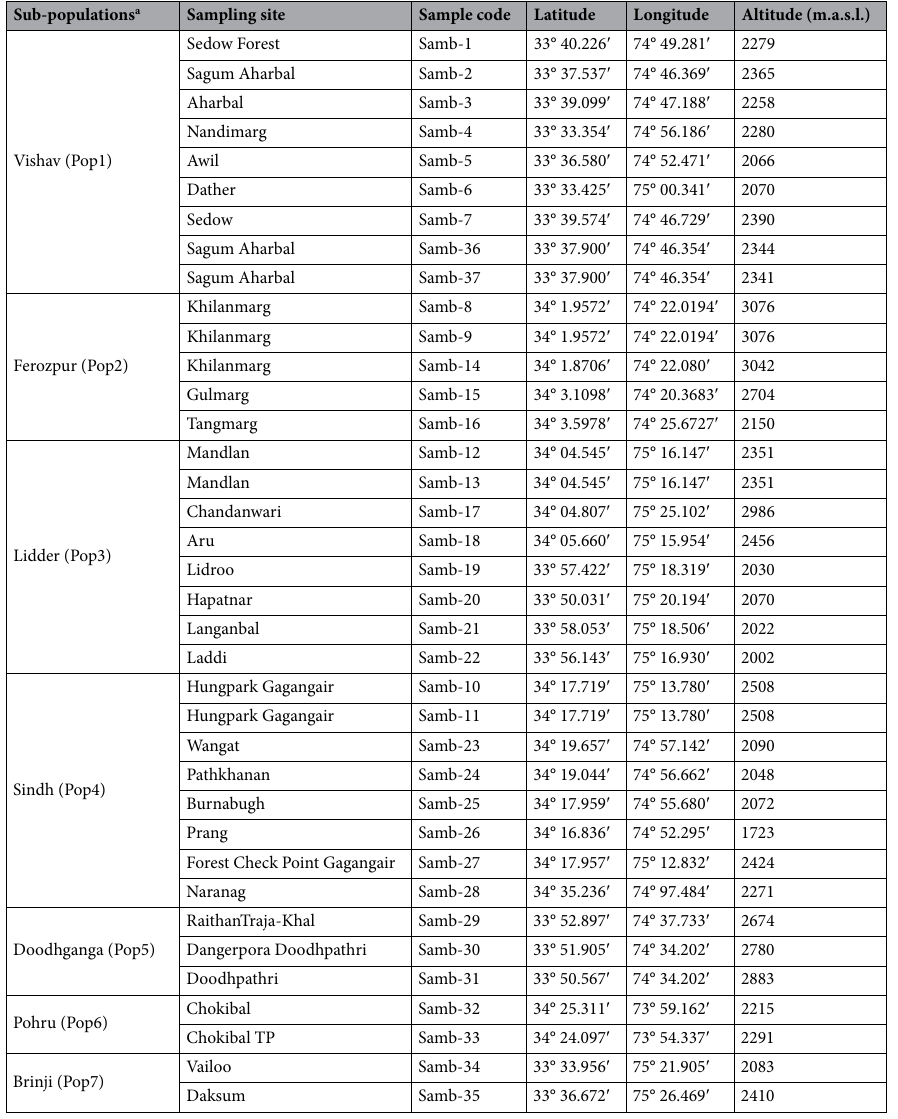
Table 9. Description of the sampling sites. a Based on the geographic location, all the samples from nearby locations were clubbed as populations for